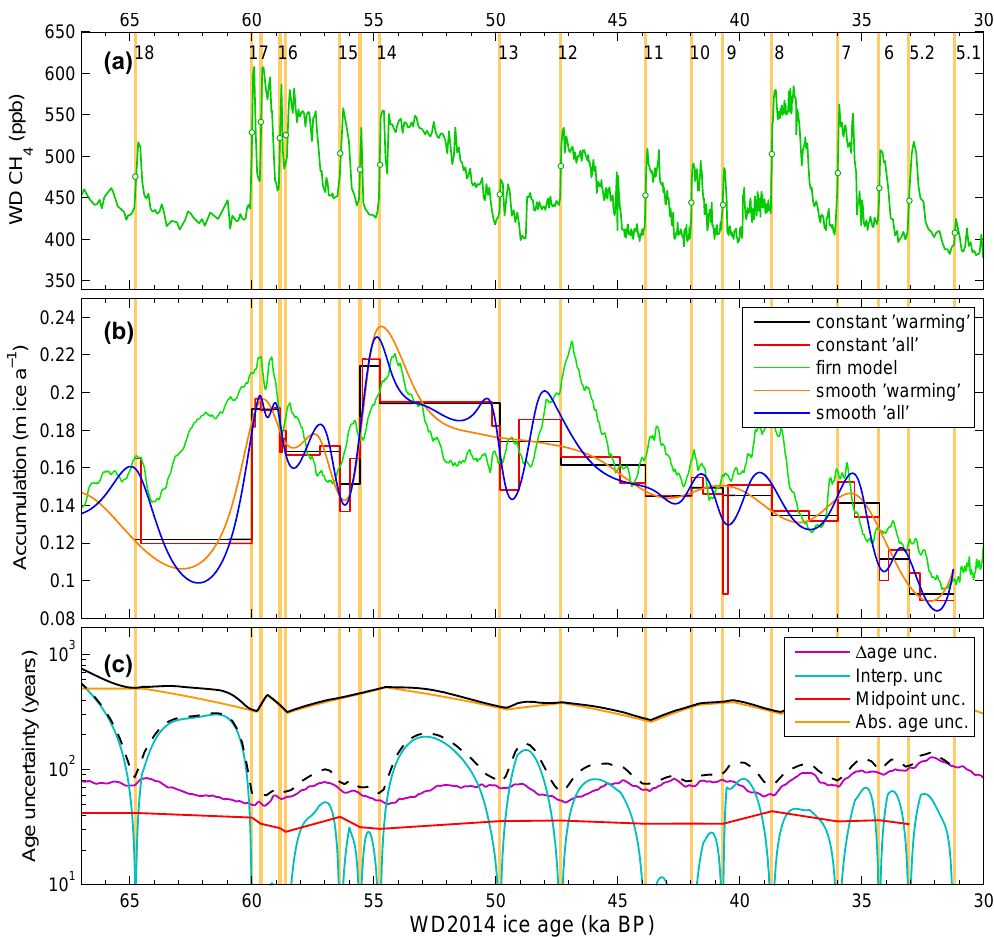
Figure 8. Interpolating between the CH 4 age constraints. (a) WD discrete CH 4 record with the abrupt stadial–interstadial transitions marked. DO numbering given at the top of the panel. (b) Different annual-layer thickness scenarios, converted to an accumulation rate for comparison to the δ 15 N-based firn model reconstructions. The interpolation strategy is to use either constant accumulation rates between tie points (“constant”) or a smoothly varying λ(z) (“smooth”); the age constraints used are either only the NH warming events (“warming”), or both the NH warming and cooling events (“all”). (c) Estimated 2 σ uncertainties in the WD2014 chronology due to (cid:49) age, choice of interpolation scheme, midpoint detection, and the absolute age constraints used in the synchronization. Total absolute ice age uncertainty plotted in solid black; relative age uncertainty (i.e., with absolute age uncertainty in the Hulu–GICC05 master chronology withheld) plotted in dashed